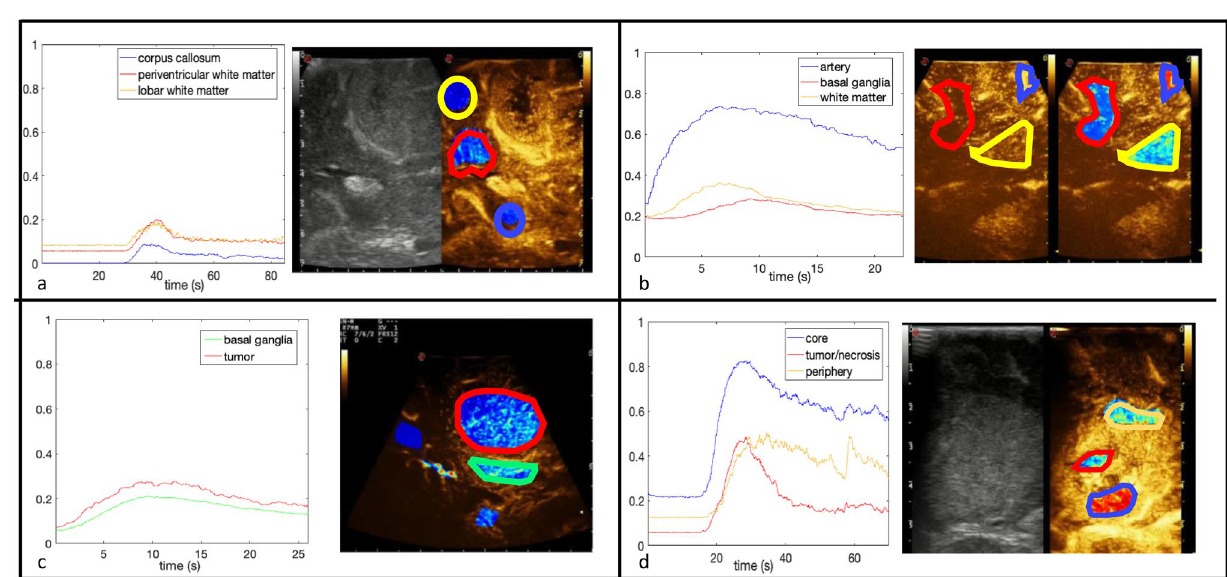
Figure 6. Differences between cerebral structure—particular cases, see text. ( a ) white matter structures; ( b ) parenchymal structures; ( c ) parenchyma and tumor; ( d ) intra-tumoral areas (x axis: frames ; y axis: